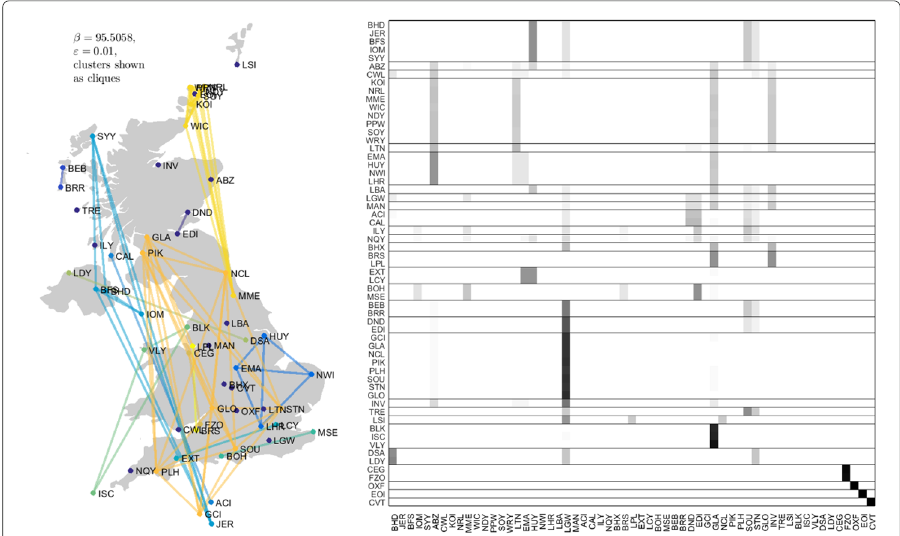
Fig. 6 Clusters from UK flight data for Tuesday, 19 October 2010; otherwise as in Fig. 5. Cluster colors only distinguish clusters from each other and do not suggest affinity across